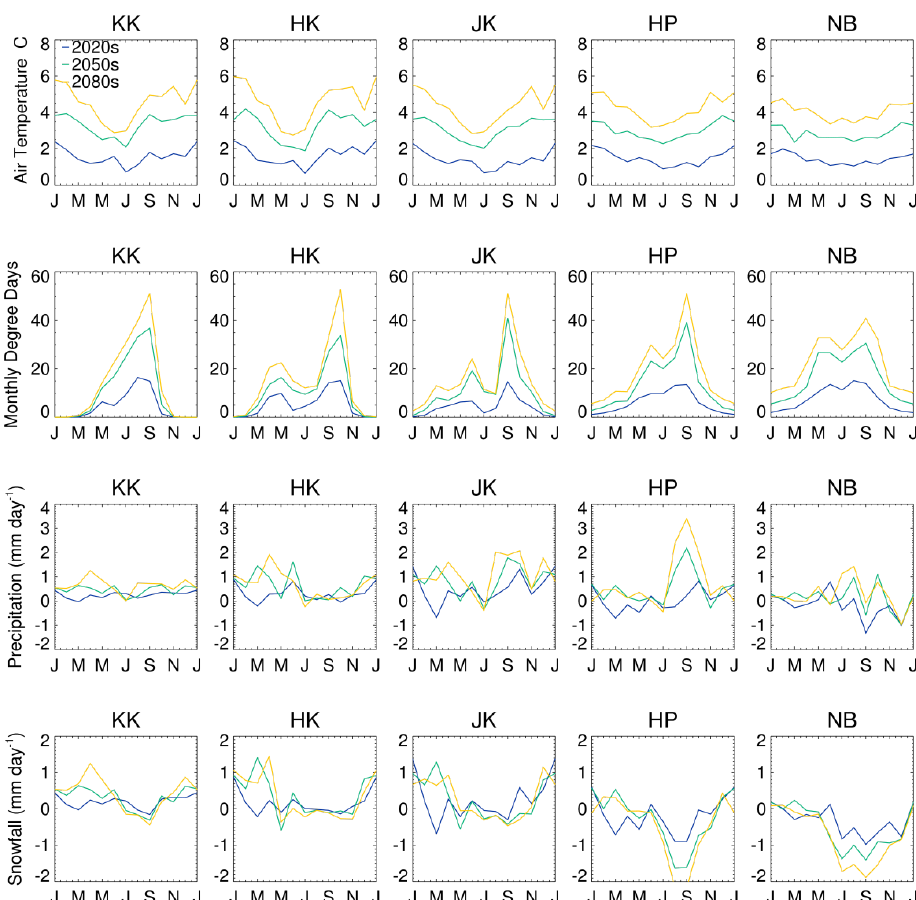
Figure 8. Thirty-year mean climatologies of air temperature, PDDs, precipitation and snowfall for the five sub-regions defined in this study from the downscaled HadCM3 A1B scenario. Shown are 30yr climatologies for, 2020s (blue), 2050s (green) and 2080s (yellow) anomalised to 1992–2008. The regions are Hindu Kush (HK), Karakoram (KK), Jammu–Kashmir (JK), Himachal Pradesh, Uttarakhand and West Nepal (HP) and East Nepal and Bhutan (NB).